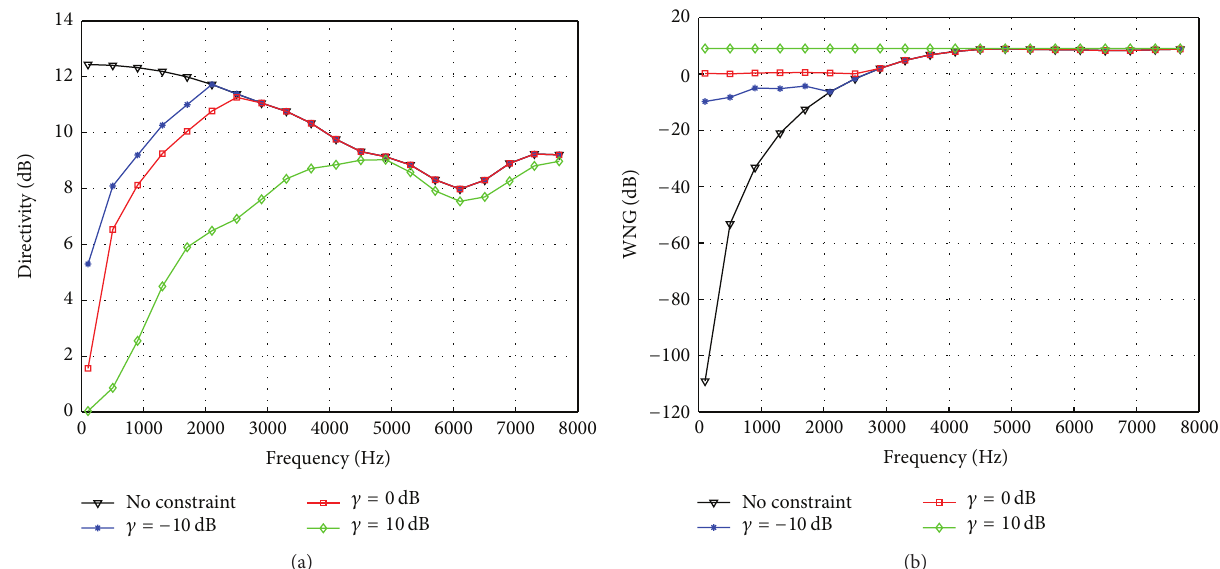
Figure 3: (a) Directivity factor and (b) white noise gain (WNG) across frequency for different values for the WNG constraint, for a circular array with 8 microphones and 0.05 m radius and a steering direction of 90 ∘ .